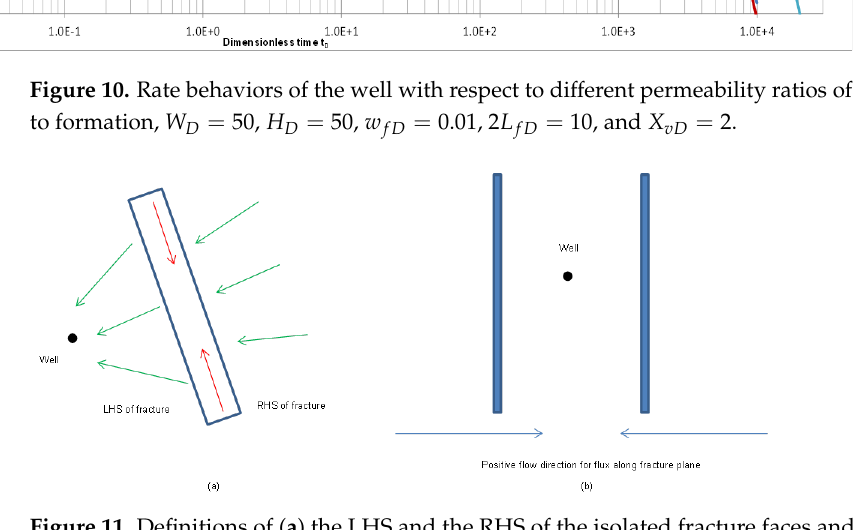
Figure 12. Flux profiles along the LHS and RHS of the isolated fracture of 𝑘 𝑓𝑟𝑎𝑐 /𝑘 𝑚𝑎𝑡𝑟𝑖𝑥 = 10,000 , with 𝑊 𝐷 = 50 , 𝐻 𝐷 = 50 , 𝑤 𝑓𝐷 = 0.01 , 2𝐿 𝑓𝐷 = 10 , and 𝑋 𝑣𝐷 = 2 . Figure 13. Flux profiles along the LHS and RHS of the isolated fracture of 𝑘 𝑓𝑟𝑎𝑐 /𝑘 𝑚𝑎𝑡𝑟𝑖𝑥 = 0.01 , with 𝑊 𝐷 = 50 , 𝐻 𝐷 = 50 , 𝑤 𝑓𝐷 = 0.01 , 2𝐿 𝑓𝐷 = 10 , and 𝑋 𝑣𝐷 = 2 .